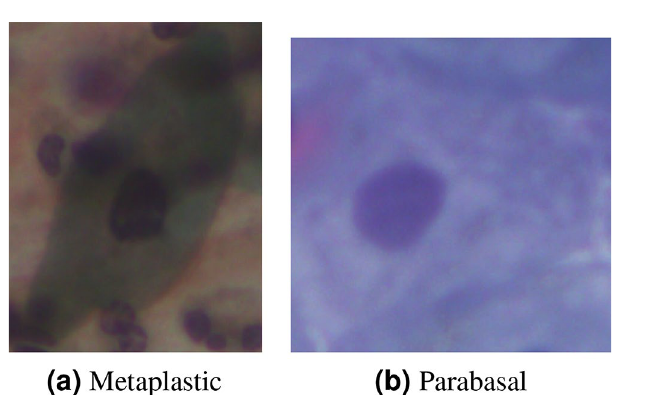
Figure 15. Comparison of the proposed ensemble model with some popular fusion techniques in literature using the same base learners: Inception v3, Xception and DenseNet-169 (image has been made by R.K. using Google Sheets).